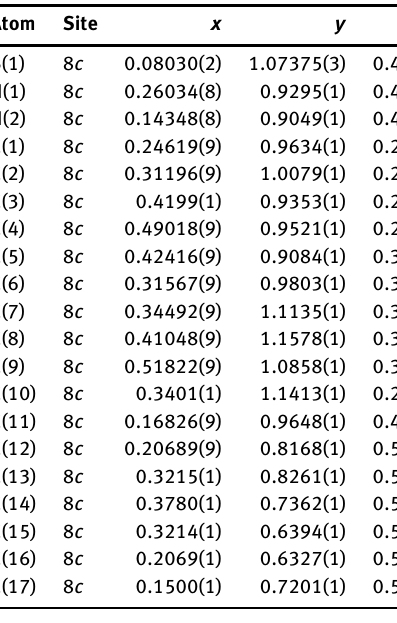
Table 3: Fractional atomic coordinate and displacement parameters (Å 2